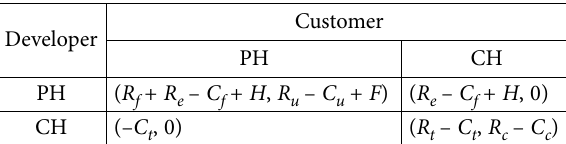
Table 2. Payment matrix between developers and customers with subsidies Developer